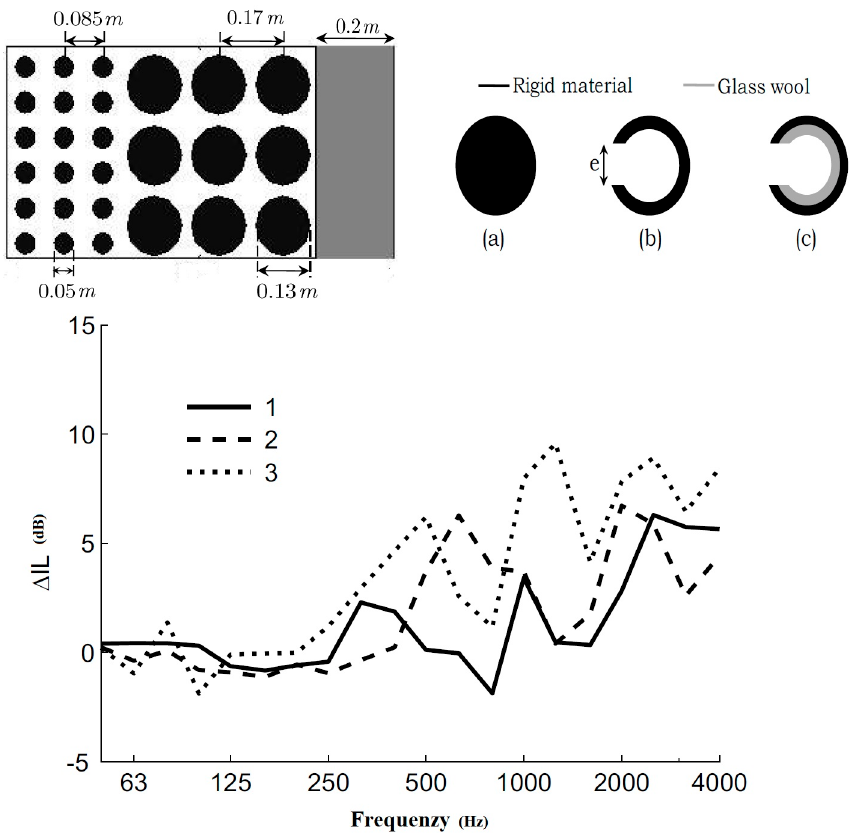
Figure 10. Insertion loss relative to a standard barrier for a coupled barrier in three different cylinder settings, modified from [52].